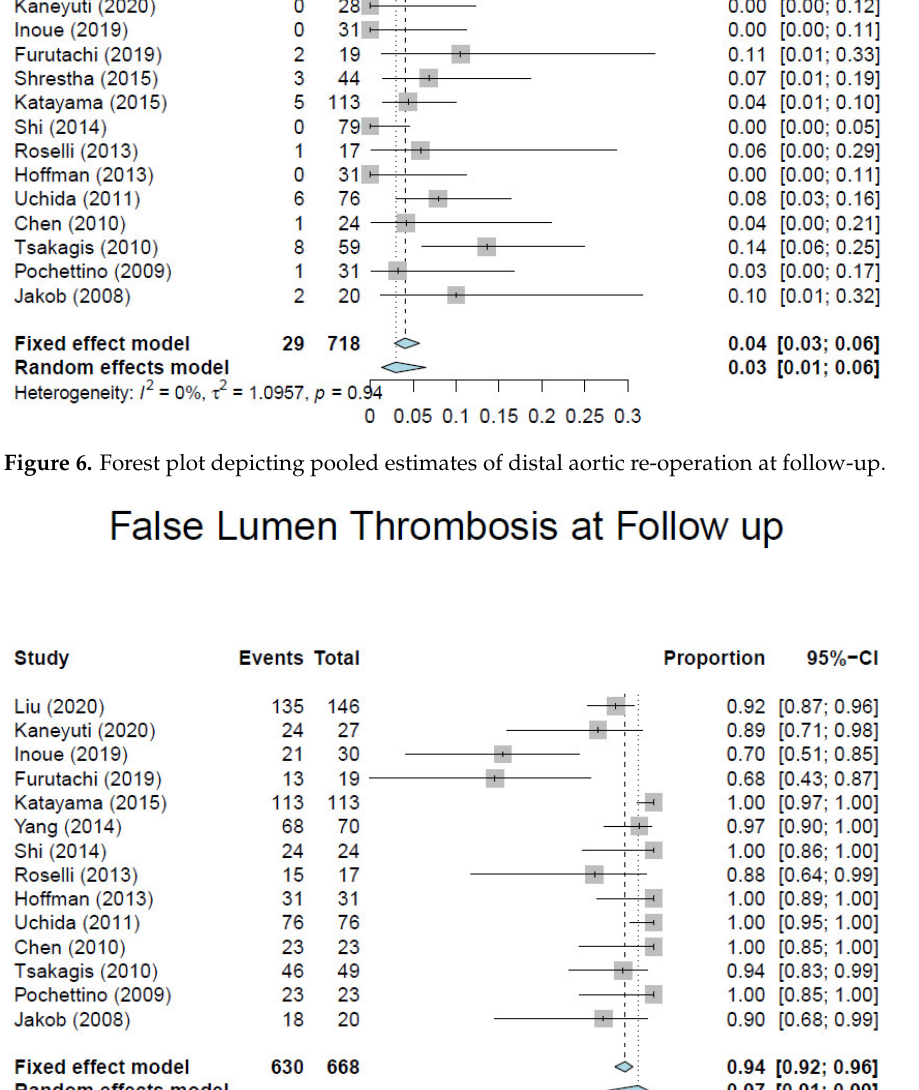
Figure 7. Forest plot depicting pooled estimates of false lumen thrombosis at follow-up. Table 1. Early outcomes after extensive ATAAD repair with Fthe ET technique.